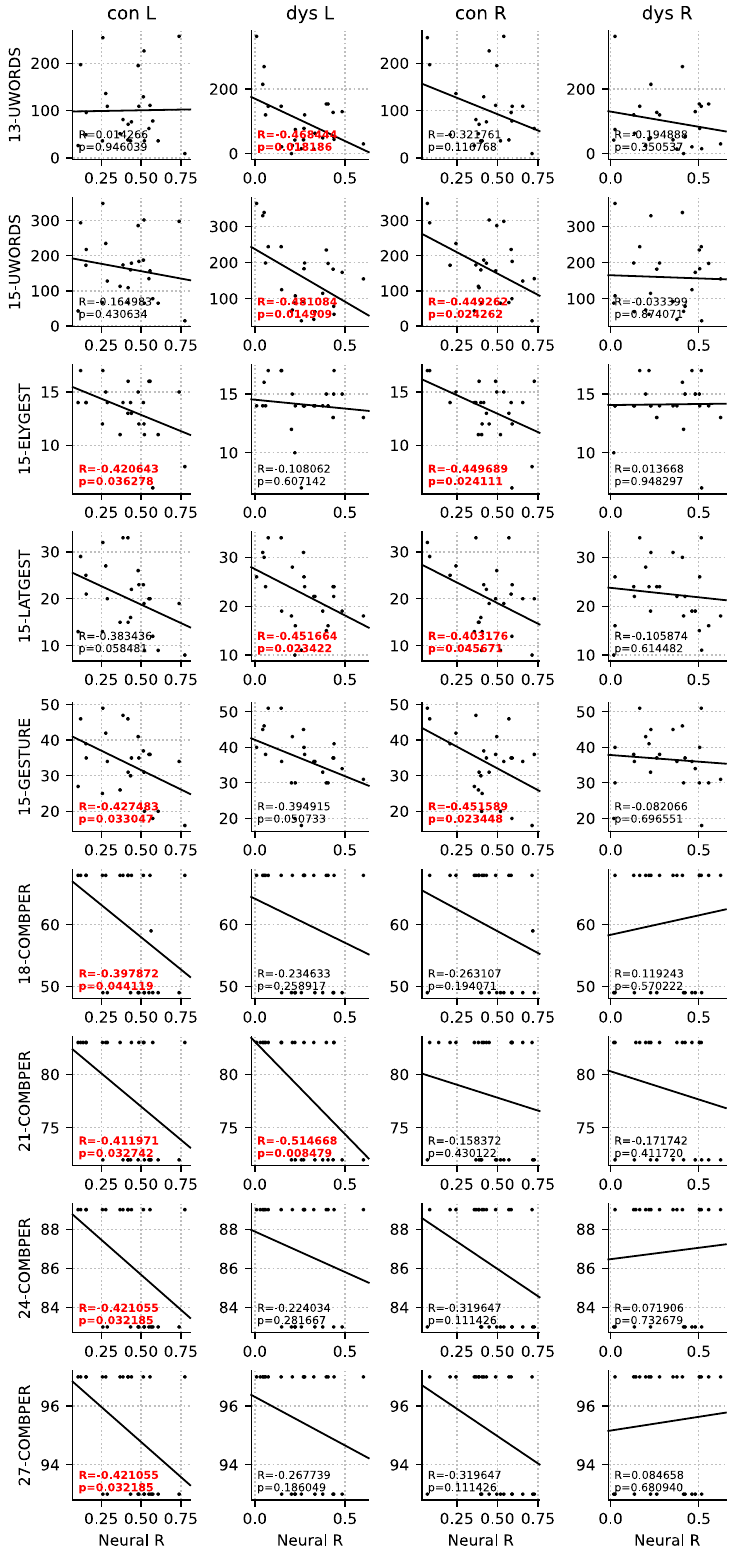
Figure 4. Scatterplots show significant correlations (p < 0.05, r - and p -values marked in red) between infants’ stimulus locking at theta (4–7 Hz) for the left and right hemisphere (L and R) and their language abilities at 13, 15, 18, 21, 24, and 27 months. Stronger left theta locking in at-risk infants predicted a lower number of words understood at 13 and 15 months. A similar pattern of response was observed in the right hemisphere for control infants. In addition, stronger left and right theta